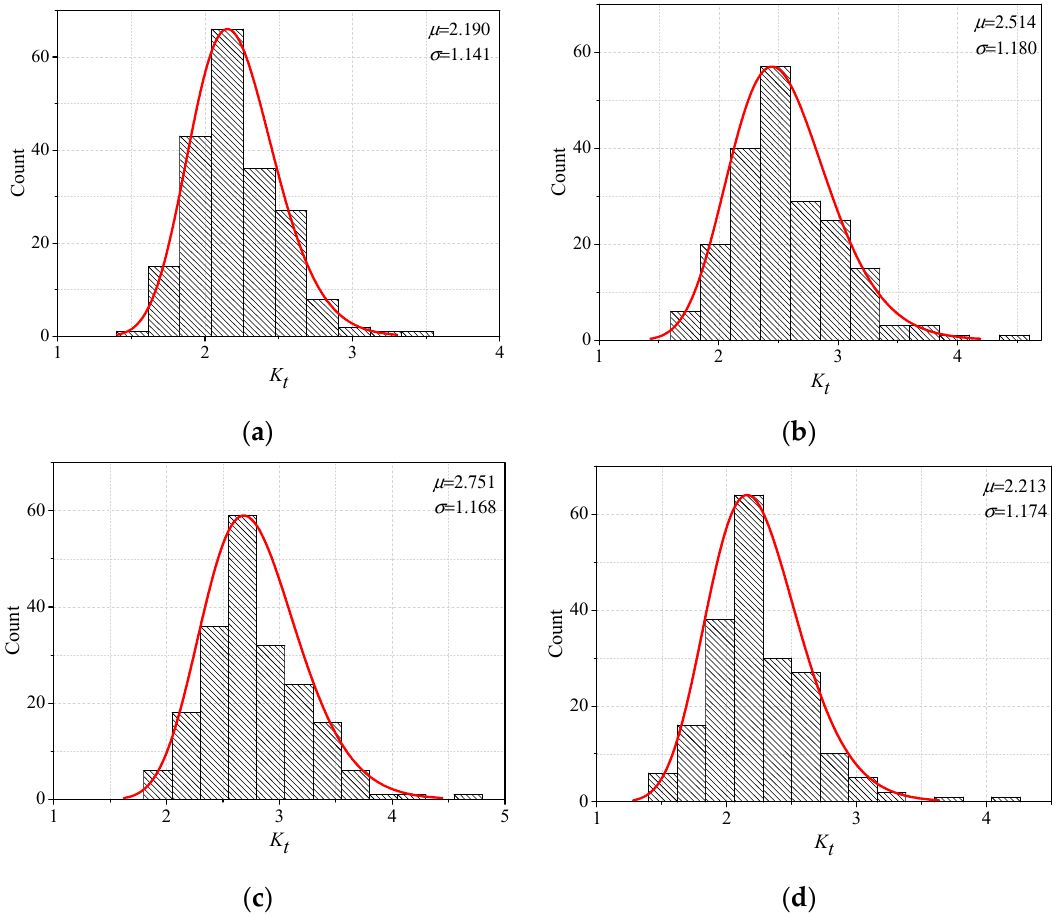
Figure 8. Probability distribution of SCF: ( a ) T-shape joint under tensile stress ( b ) T-shape joint under bending stress; ( c ) cruciform joint under tensile stress; ( d ) cruciform joint under bending stress.